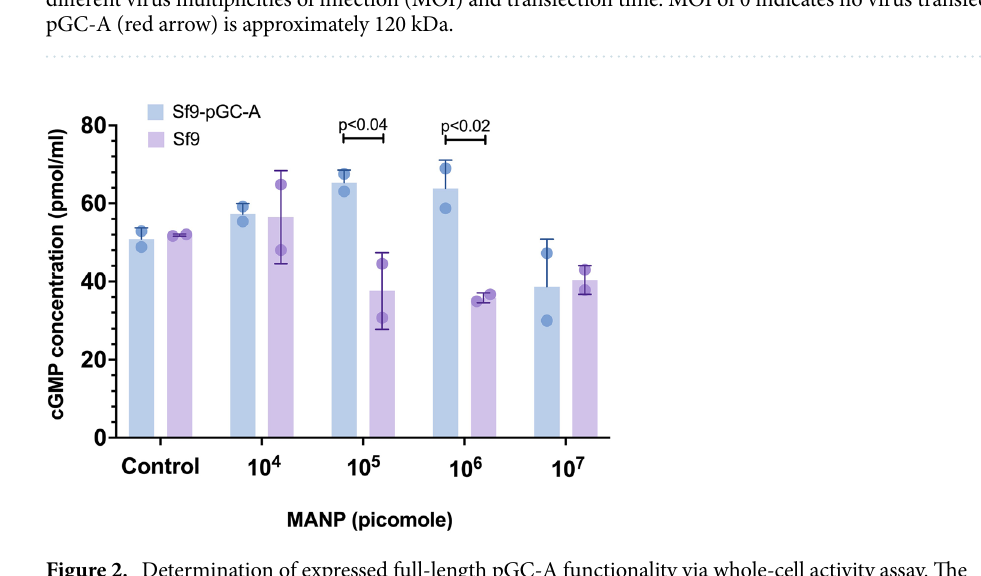
Figure 2. Determination of expressed full-length pGC-A functionality via whole-cell activity assay. The competitive ELISA assay measured the cGMP yield level in Sf9 cells expressing full-length pGC-A versus control Sf9 cells (n = 2). Both cell types were incubated with different concentrations of MANP ligand (0 to 10 7 pmol). Incubation with 0 pmol MANP served as a negative